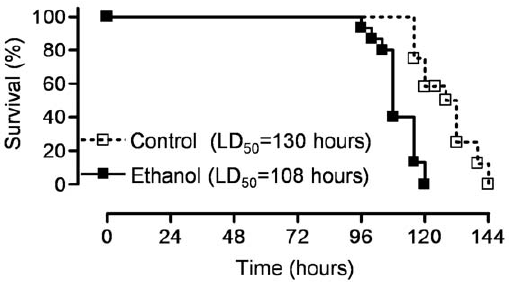
Figure 1. Alcohol accelerates mortality from hyperoxia- induced acute lung injury in mice. Mice were treated with ethanol (20% v/v, 4 g/kg i.p.) or control vehicle (sterile water) daily starting 3 days prior to and during the first 2 days of exposure to hyperoxia ( . 95% O 2 ) for a total of 5 days. The time when 50% of the animals had died (LD 50 ) was calculated. (N=8/group for each treatment group).